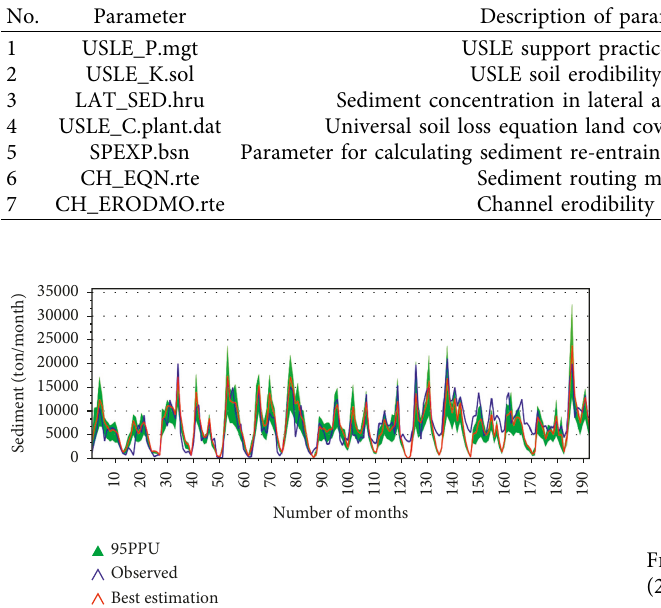
Figure 11: Monthly calibrated sediment yield hydrograph at the Awata station.